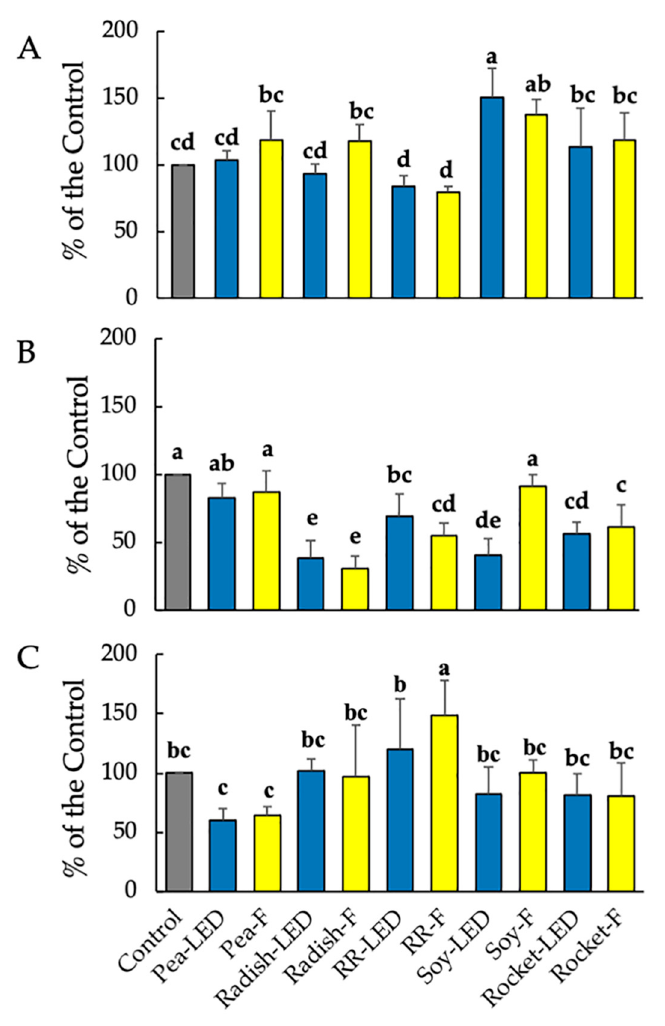
Figure 4. Cell vitality (MTT assay) on healthy L929 fibroblasts ( A ), 2D RD-ES ( B ), and 3D RD-ES ( C ) exposed for 24 h to 20 μ L green pea, radish, Red Rambo (RR), soybean (soy), and rocket microgreen extracts, cultivated under LED and fluorescent (F) lighting. Values are the mean ± SD of six replicates ( n = 6). The different lowercase letters (a–e) within each graph represent significant differences between the microgreens under different lighting for each treatment ( p < 0.05), as determined from a one-way ANOVA.